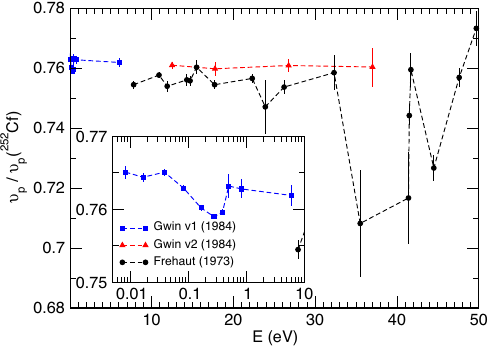
Figure 1. Prompt neutron multiplicity experimental data from Fréhaut [6] and Gwin [4, 5] up to 50 eV normalized to the ν p of 252